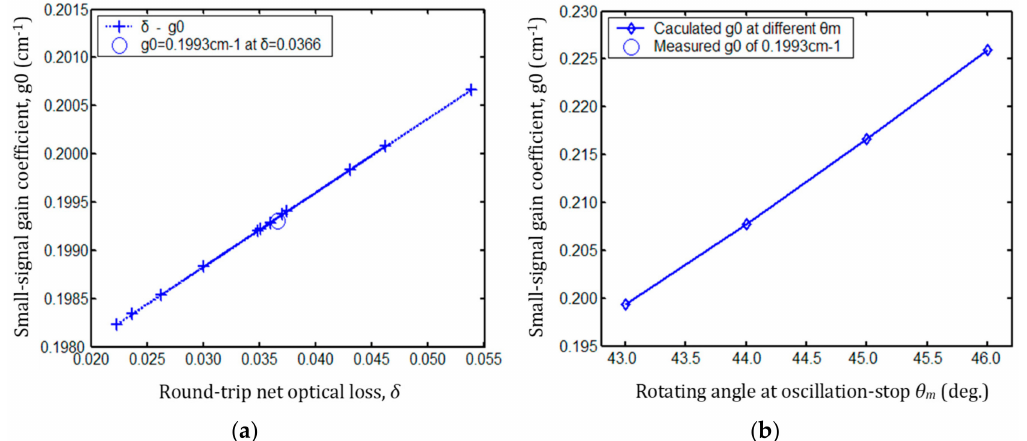
Figure 8. Measured deviation of the small-signal gain coe ffi cient g 0 . ( a ) Small-signal gain coe ffi cient g 0 with respect to di ff erent values of δ . ( b ) Small-signal gain coe ffi cient g 0 influenced by the measured oscillation-stop angle θ m